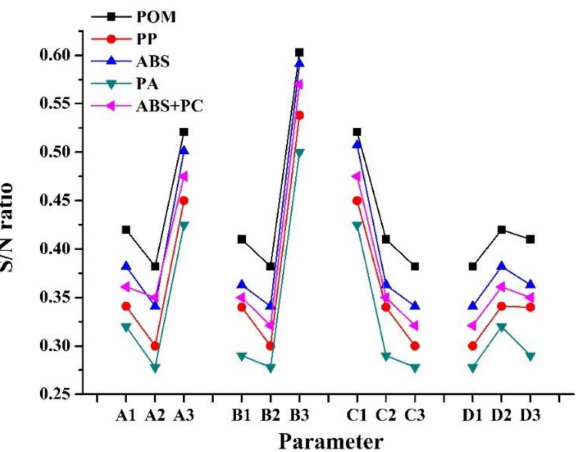
Figure 10. Variation of the S/N ratio with factor level for warpage phenomenon of micro-sized part by experiment (POM/ABS/PP/PA/ABS +